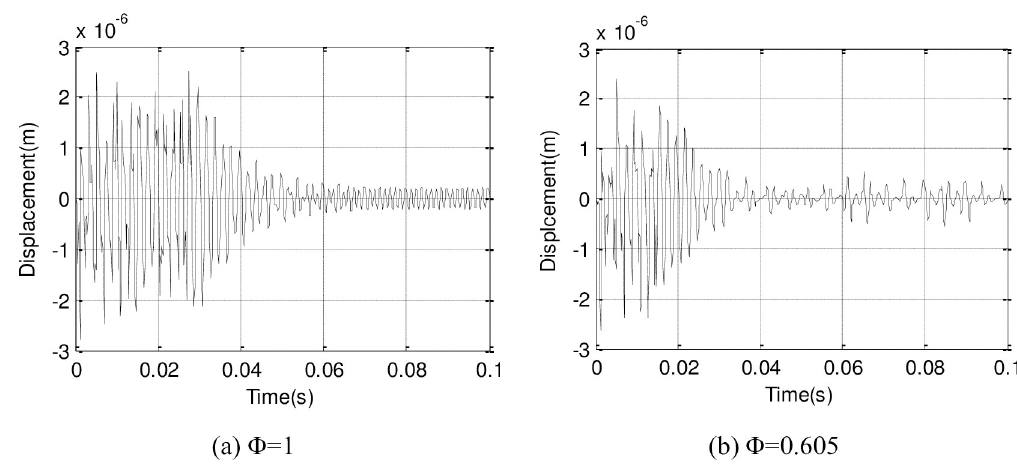
Fig 13. X direction displacement response of second-stage blade.